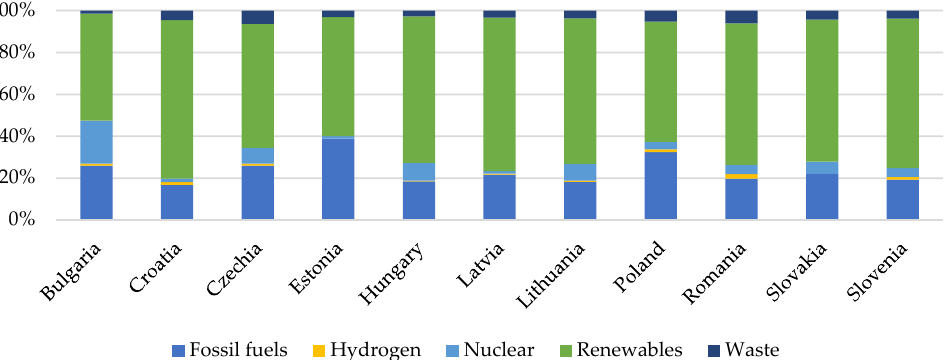
Figure 13. Type of source by country. Source: Authors; N = 4111. Note: This figure shows research on different energy sources in the 11 CEE countries and therefore the number of cases differs; for example, a comparative study on three countries’ utilization of coal was coded separately for each country.